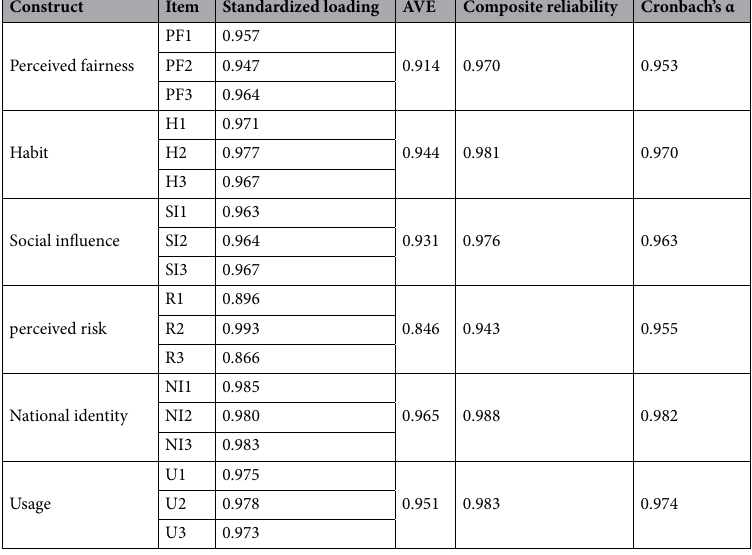
Table 3. Convergent validity, composite reliabilities testing results. R perceived risk, SI social influence, PR perceived fairness, H habit, NI national identity, U usage.